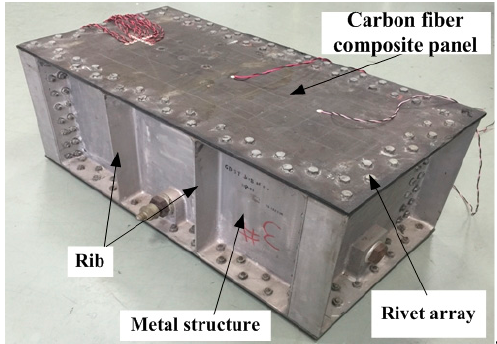
Figure 4. The fuel tank structure.